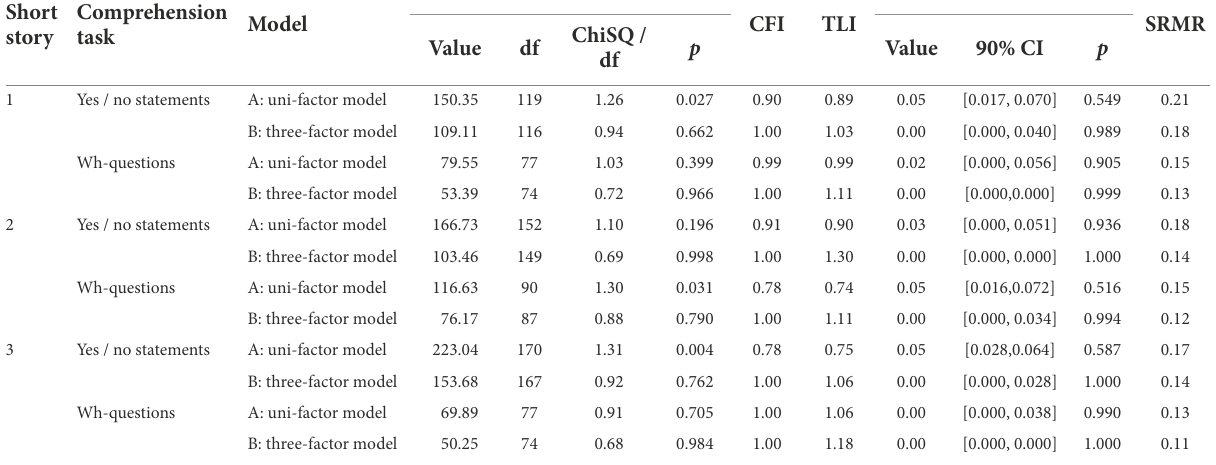
TABLE 3 Model fit per text.